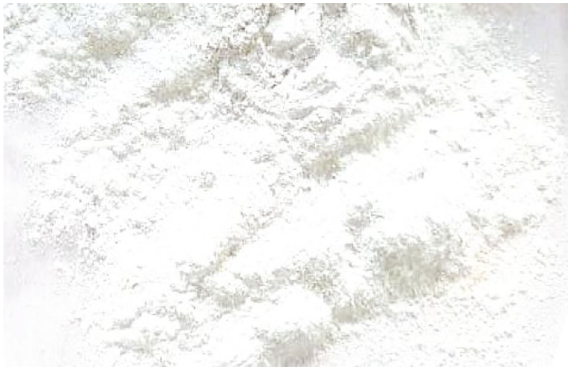
Figure 1: Dry sugar beet